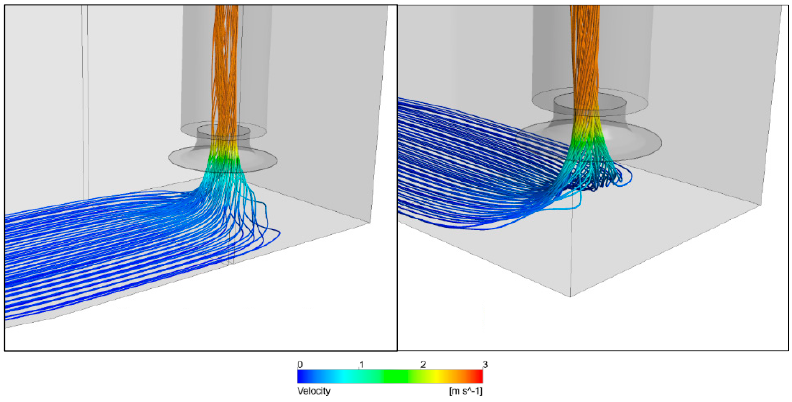
Figure 9. Flow streamline near the bottom of the sump indicating steady and uniform approach flow towards the pumps.